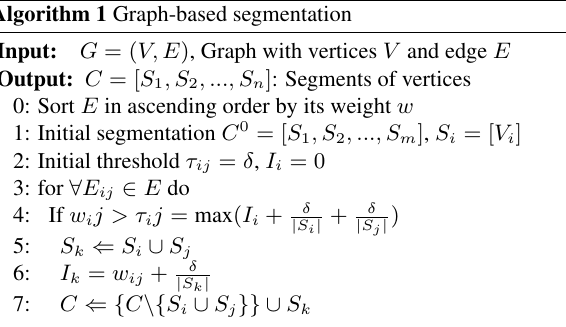
Algorithm 1 Graph-based segmentation